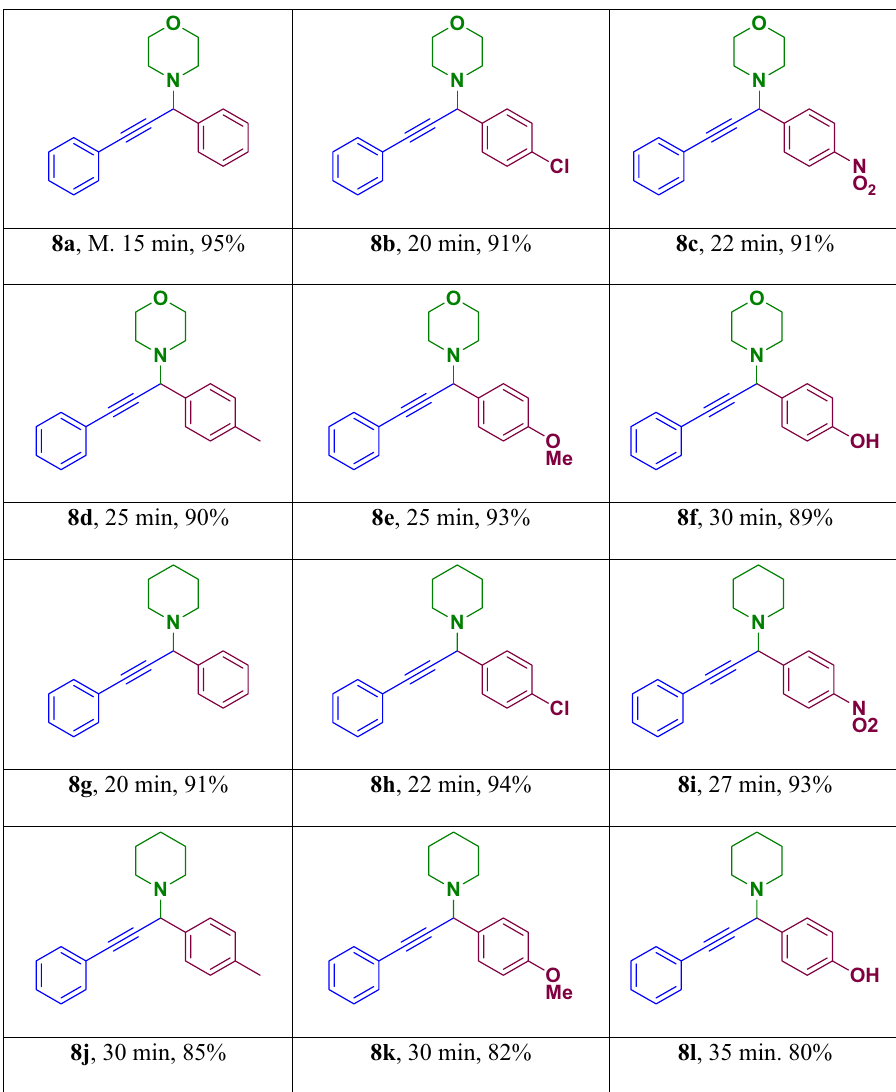
Table 3. A 3 and KA 2 coupling reactions in the presence of Fe 3 O 4 -g- C 3 N 4 -Alginate-Ag 55,56